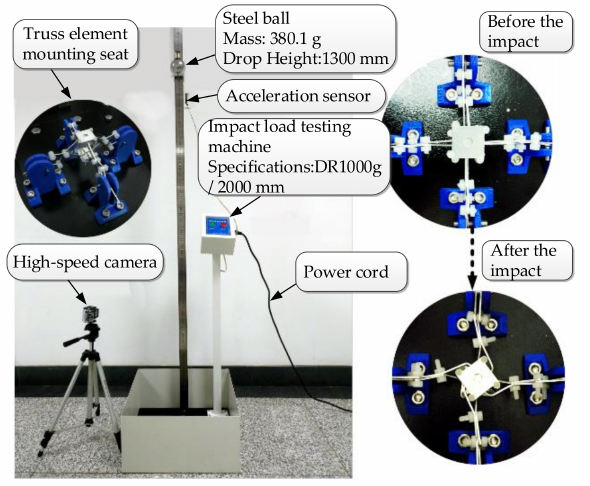
Figure 6. Experimental device and impact test.